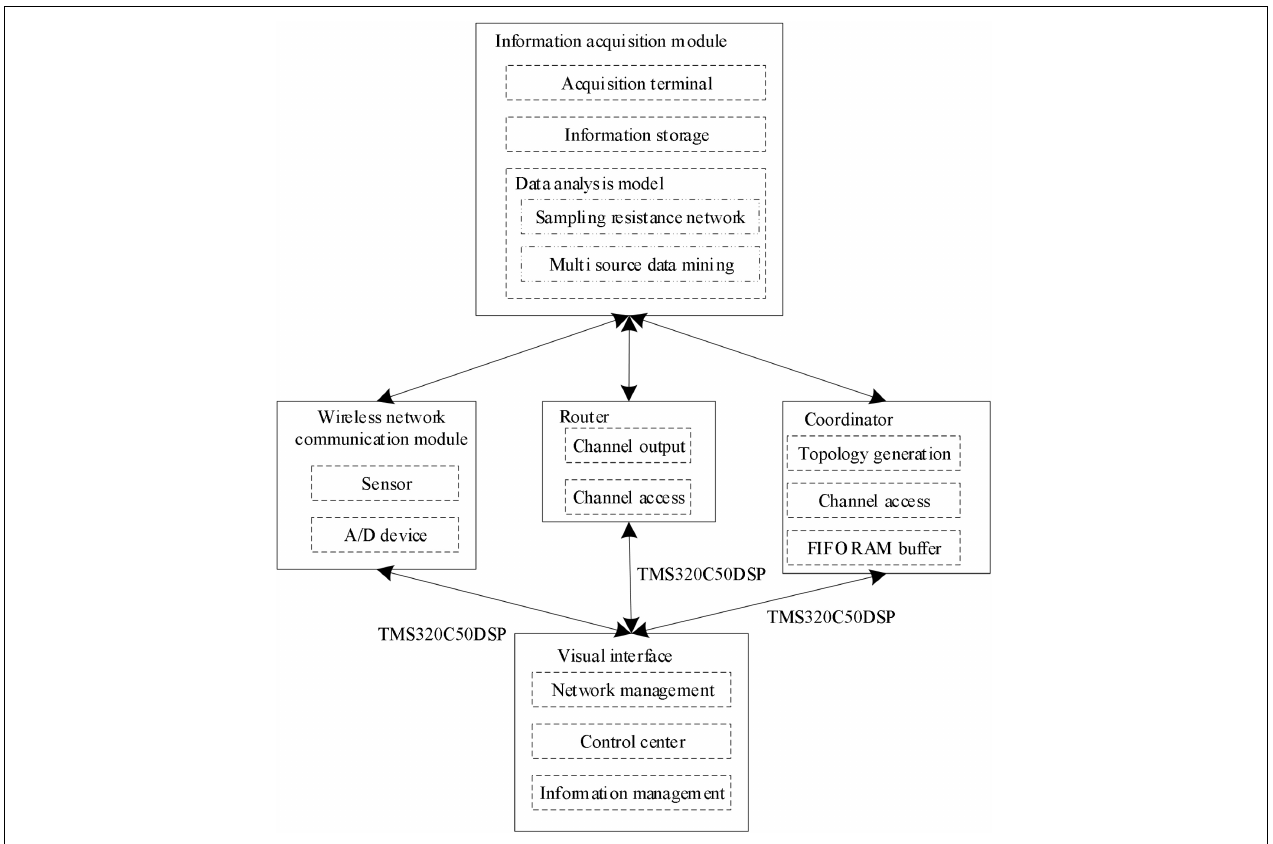
FIGURE 6 | Technical framework of sport intensity information